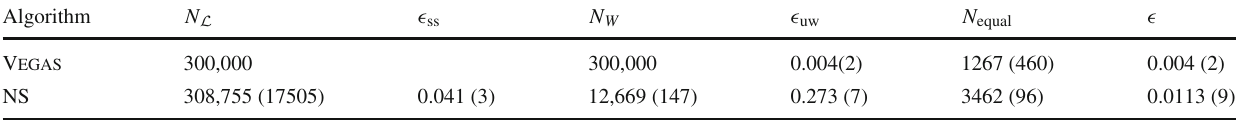
Table 1 Comparison of V EGAS and NS for the toy example in terms of size of event samples produced. N L gives the number of target evalua- tions, N W thenumberofweightedeventsand N equal thederivednumber of equal weight events. A MC slice sampling efficiency, (cid:10) ss , is listed for